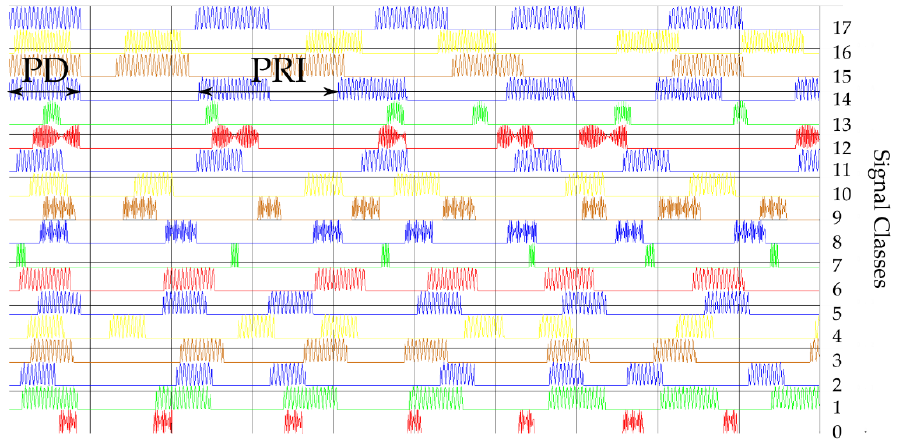
Figure 4. Examples of generated waveforms for the parameters PD and RF for 18 classes.